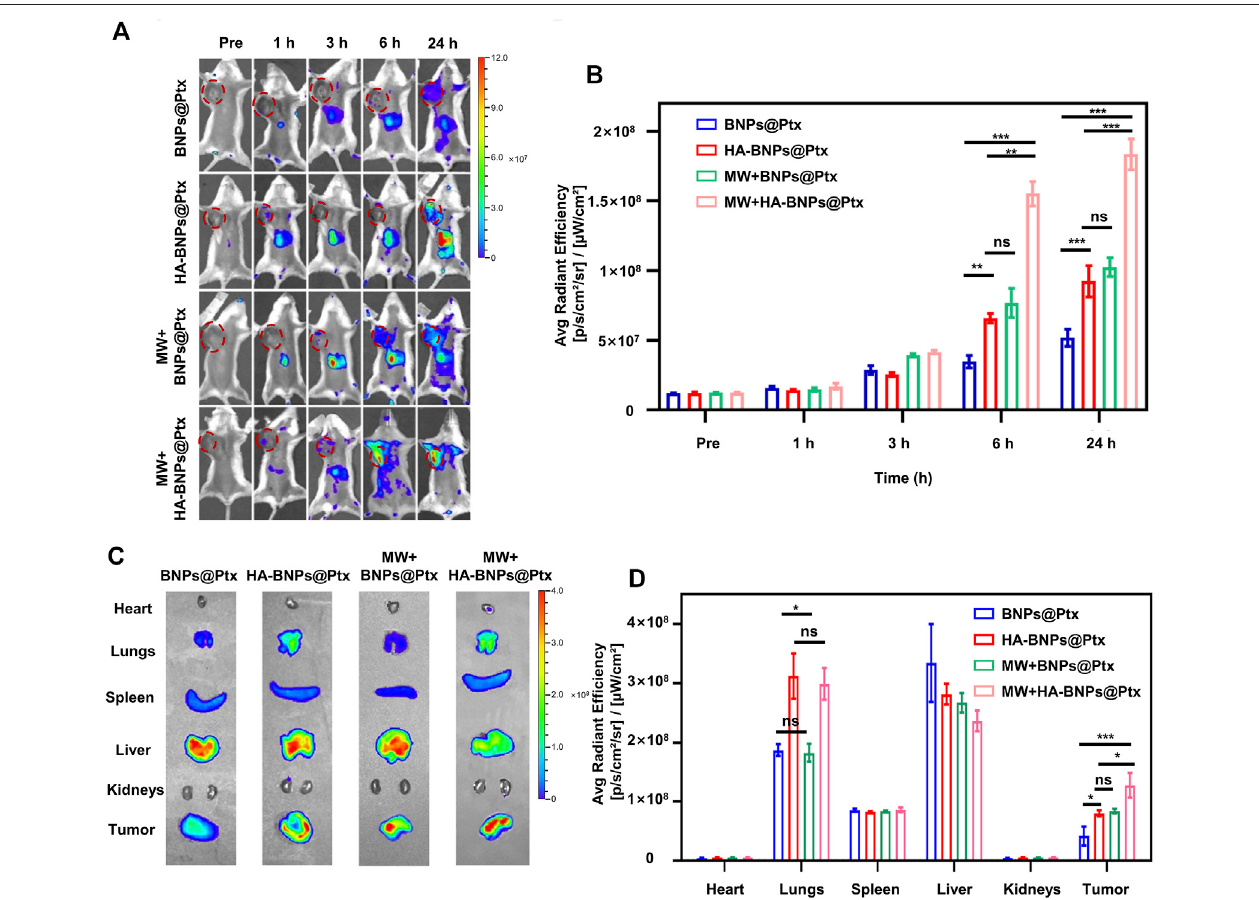
FIGURE 5| In vivo targeting ability and biodistribution of nanoparticles. (A) Representative in vivo fl uorescence images of 4T1 breast tumor-bearing mice obtained at pre-injection, 1, 3, 6, and 24 h after intravenous injection of Dil-BNPs@Ptx and Dil-HA-BNPs@Ptx (0.5 μ l/g) with or without fi rst MW irradiation. (B) Average radiant intensity determined from in vivo fl uorescence imaging for tumor-targeted (Dil-HA-BNPs@Ptx) and non-targeted (Dil-BNPs@Ptx) nanoparticles with or without fi rst MW irradiation. (C) Ex vivo fl uorescence images of main organs and tumor collected from tumor-bearing mice 24 h after injection of nanoparticles. (D) Average radiant intensityofmainorgansandtumordeterminedfrom exvivo fl uorescenceimagingforfouranimalgroupsat24 hafterinjectionofnanoparticles.Thedataarepresentedas mean ± SD ( n (cid:2) 6, ns, not signi fi cant; * p < 0.05, ** p < 0.01, *** p < 0.001).